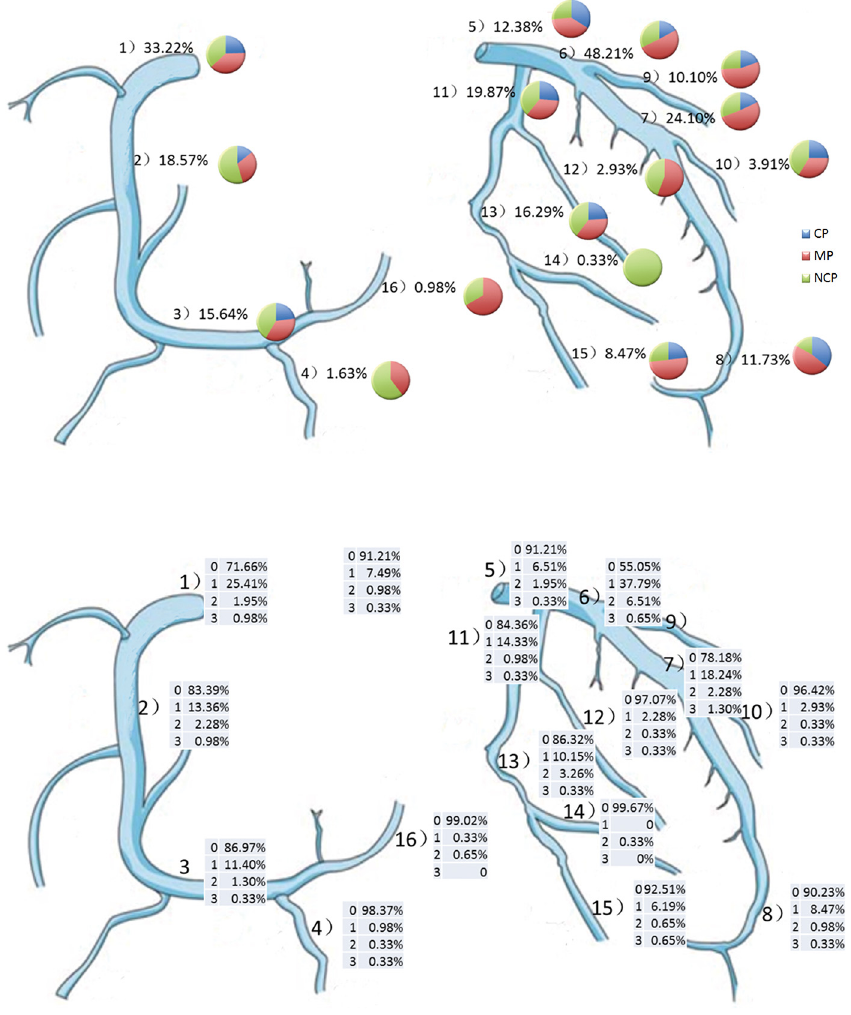
Fig 2. The spectrum of atherosclerosis burden in each segment of coronary artery tree. The coronary artery tree was classified into 16 segments according to American Heart Association classification 1] proximal, 2] mid, 3] distal right coronary artery; 4] posterior descending artery; 5] left main artery; 6] proximal, 7] mid, 8] distal left anterior descending artery; 9] first, 10] second diagononal branch; 11] proximal, 13] mid, 15] distal left circumflex artery; 12] first, 14] second obtuse marginal branch; 16] posterolateral ventricular branch]. The degree of stenosis and composition of plaque of each segment was evaluated. The incidence of plaque and proportion of plaque (CP, MP, NCP) were noted on each segment in fig 2 (top). The degree of stenosis of each segment was classicized into four groups: 0 for normal, 1 for < 50%,2 for 50% to 69%, 3 for (cid:1) 70% and their proportion were recorded in fig 2 (lower). CP = calcified plaques. MP = mixed plaques. NCP = non-calcified plaques.